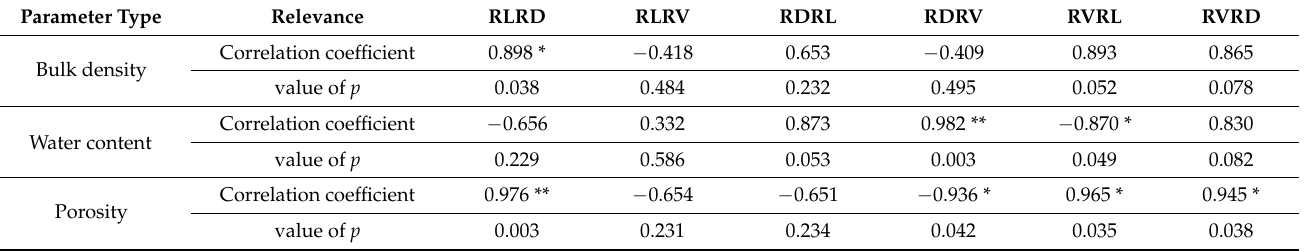
Table 6. Biased correlation analysis of tailings containing Paspalum notatum Flugge (* p < 0.05 ** p <